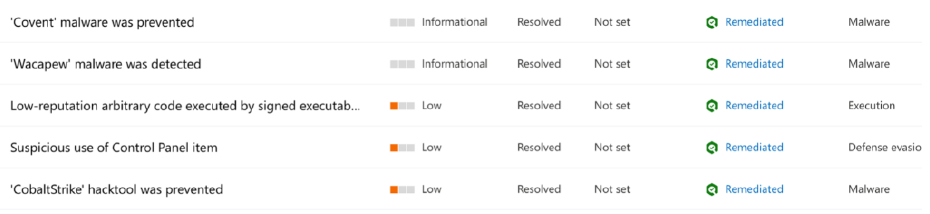
Figure 27. Alerts produced by ATP in